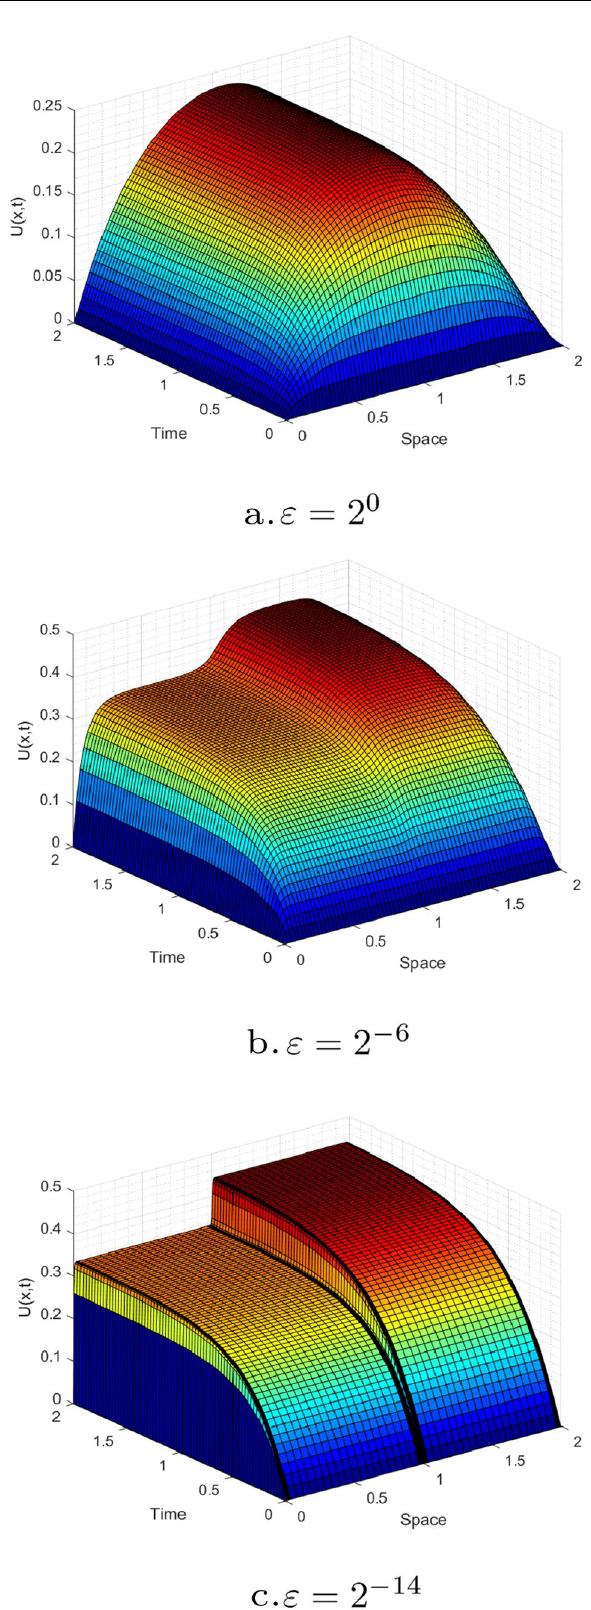
Fig. 2 Simulations for the numerical solution of Example 2, taking 𝜃 =0.5, 𝛽 =1.5, N =64 and M =32 at different time levels and perturba- tion parameters (line